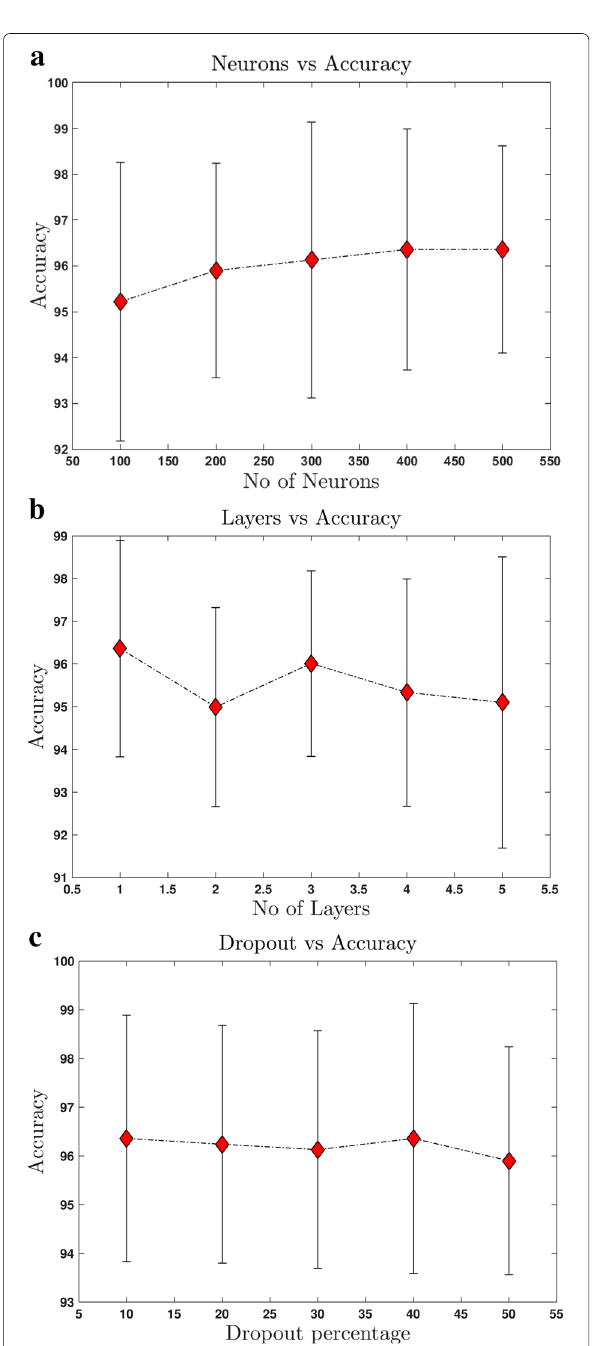
Fig. 23 Effect of parameters on KPA3 + KPD2 + GKPD2 + GKPCD2 KPF. a Number of neurons in the first hidden layer versus the accuracy of the model. The standard deviation is shown as verticallines . b Number of layers vs the accuracy. c Dropout with accuracy